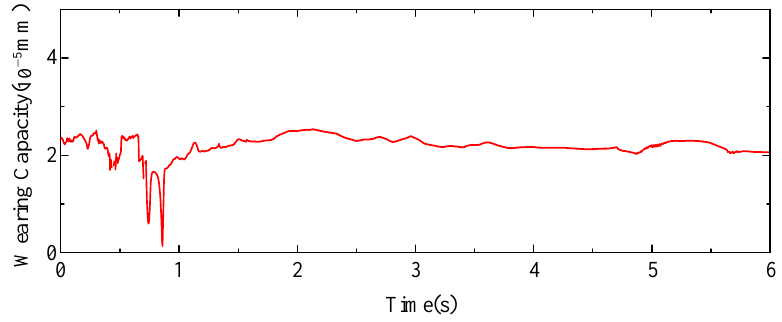
Figure 14. Dynamic wear on the surface of the sleeve.